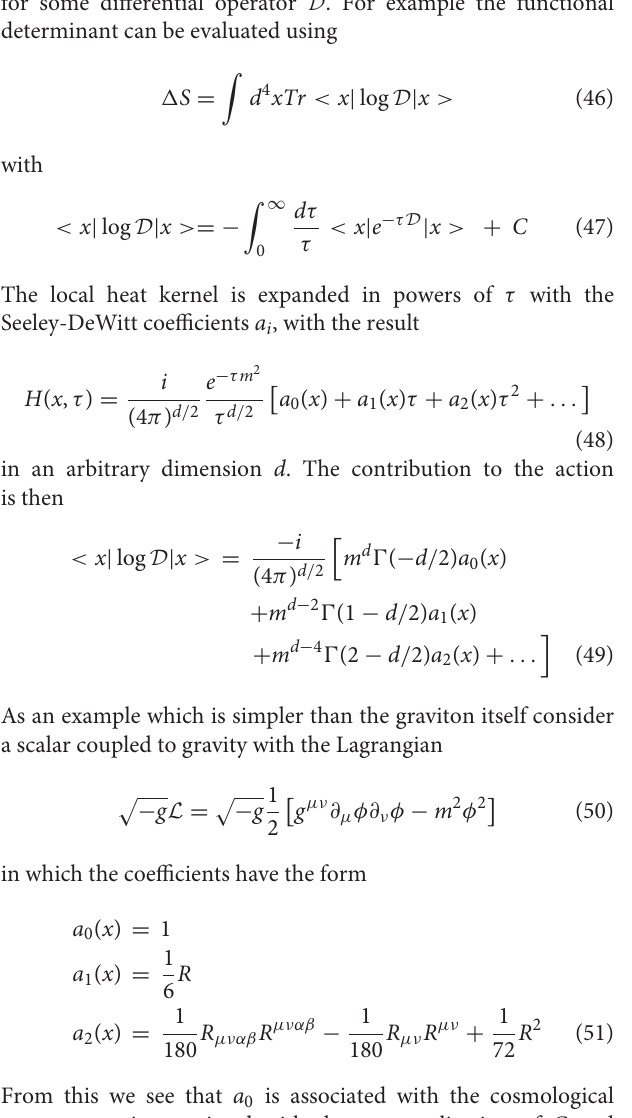
FIGURE 1 | The tadpole diagram on the left has an insertion of an operator involving the background field. When applied, this operator is expanded in powers of the external field, as on the right-hand side. The momenta of the external fields do not flow through the